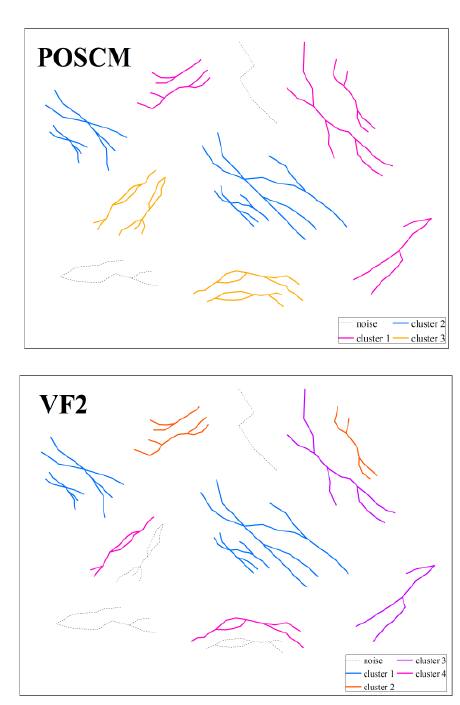
Figure 4. Clustering results based on structural